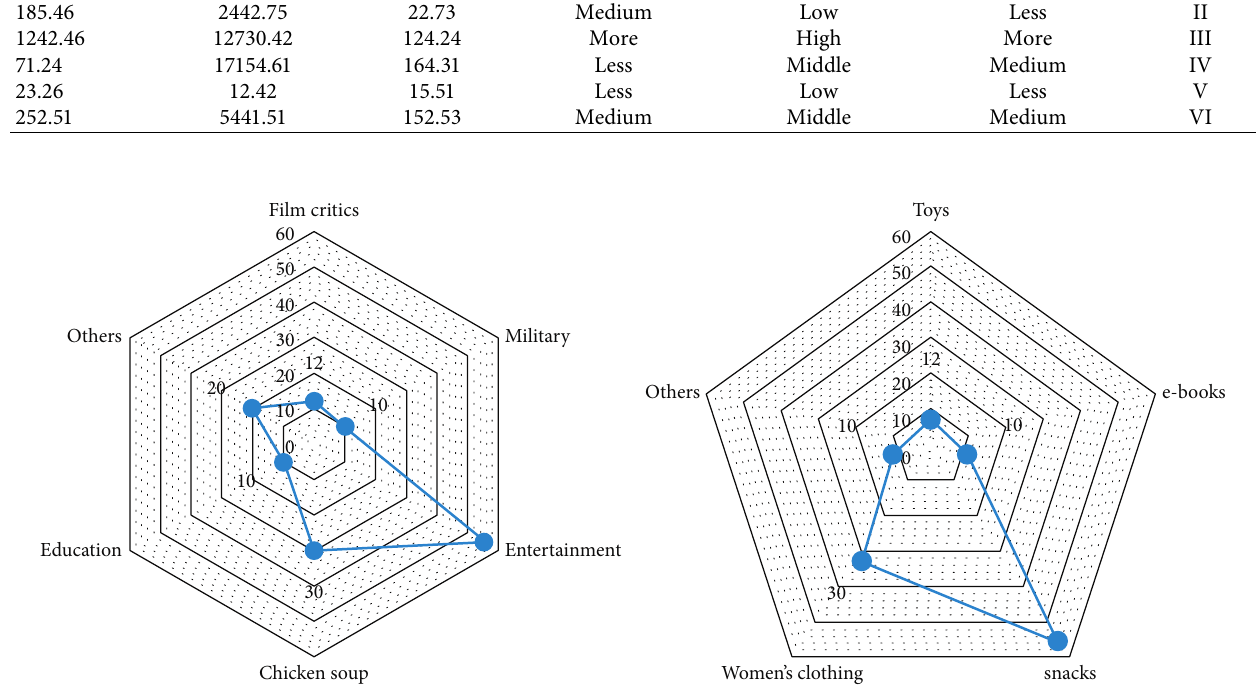
Figure 9: Diagram of user